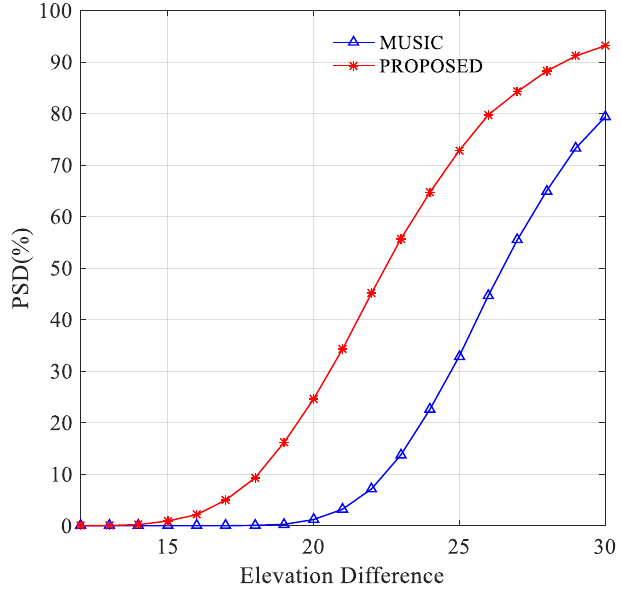
Figure 9. PSD versus elevation difference.